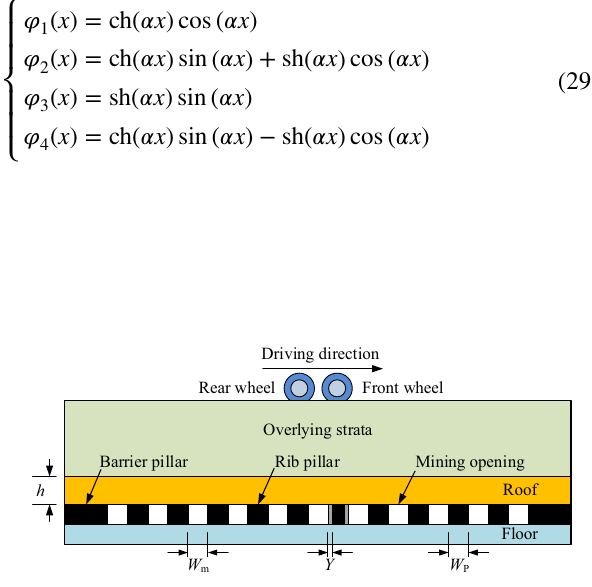
Fig. 5 Elastic foundation beam model composed of the rib pillar and the roof